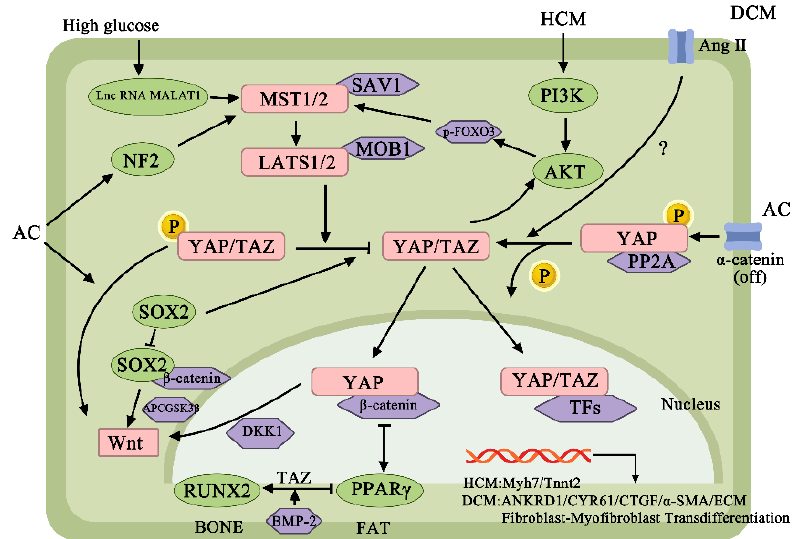
Figure 3. YAP/TAZ signaling proteins in cardiomyopathy. SAV1, salvador homolog-1; MOB1, MOB kinase activator 1; p-FOXO3, phospho-forkhead box O3; SOX2, SRY-box transcription factor 2; ADCGSK3 β , glycogen synthase kinase-3 β ; BMP-2, bone morphogenetic protein 2; PP2A, protein phosphatase 2A; α -SMA, α -smooth muscle actin.